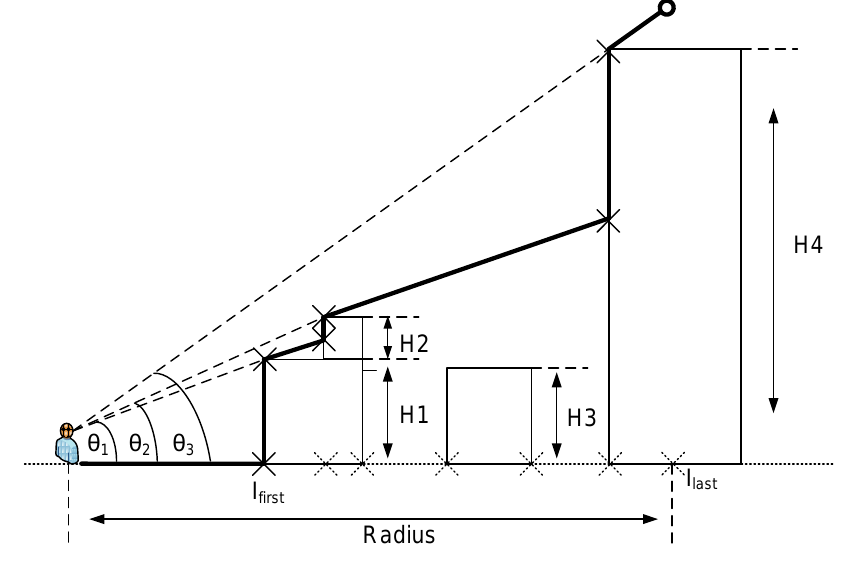
Figure 8. Search Algorithm 2 determining sight line intersections in a true 3D